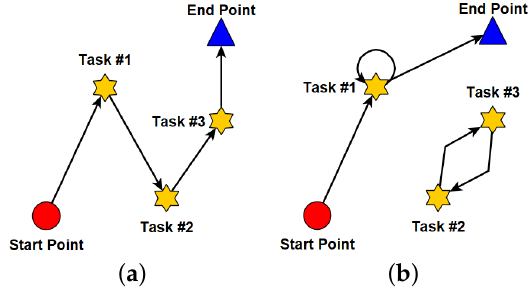
Figure 3. Paths without loops and with loops. ( a ) without loops; ( b ) with